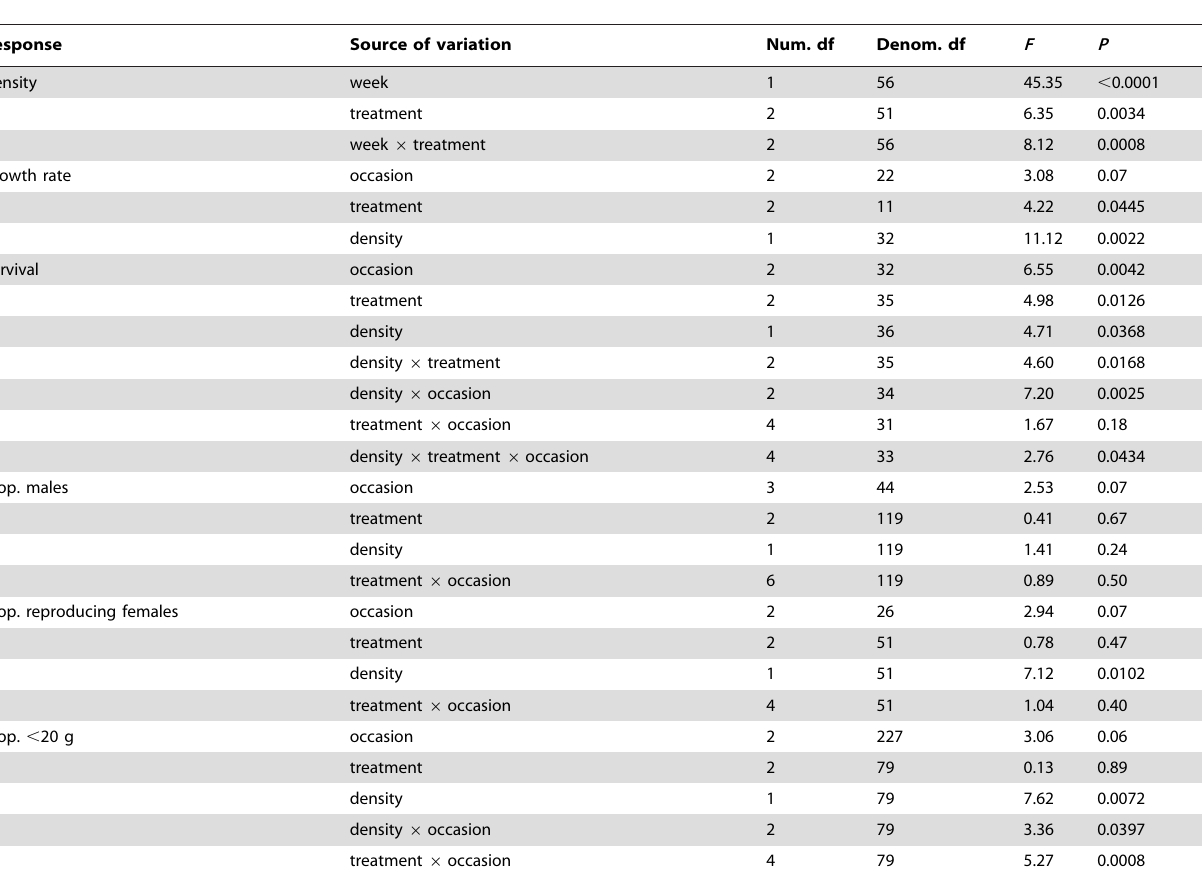
Table 1. Most parsimonious model to explain each response variable.